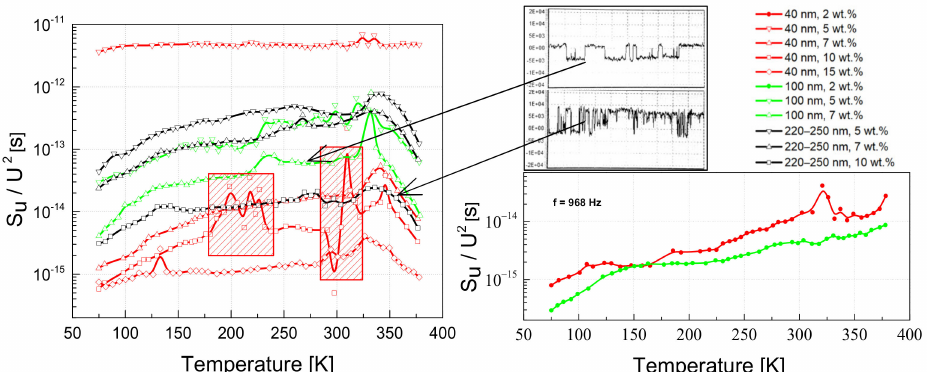
Figure 10. Dependence of the voltage noise spectral density on temperature for different composites with OLC particles, at a fixed frequency of 968 Hz. The shaded red rectangles denote the region where impulse noise was observed; impulse noise oscillograms are presented in the inset.